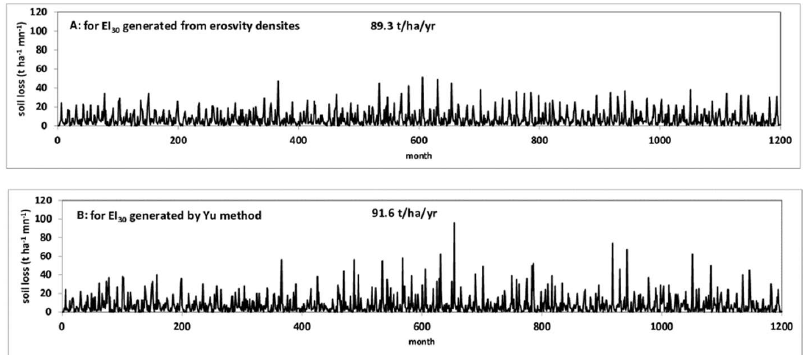
Figure 10. Average annual soil losses from bare fallow and cropped areas predicted by RUSLE2 when using CLIGEN for 100 years at seven locations in the USA ( A ) when using R d values generated by the Yu method, and ( B ) when using R d values based on RUSLE2 erosivity densities (source: Kinnell and Yu (under review) [57]).